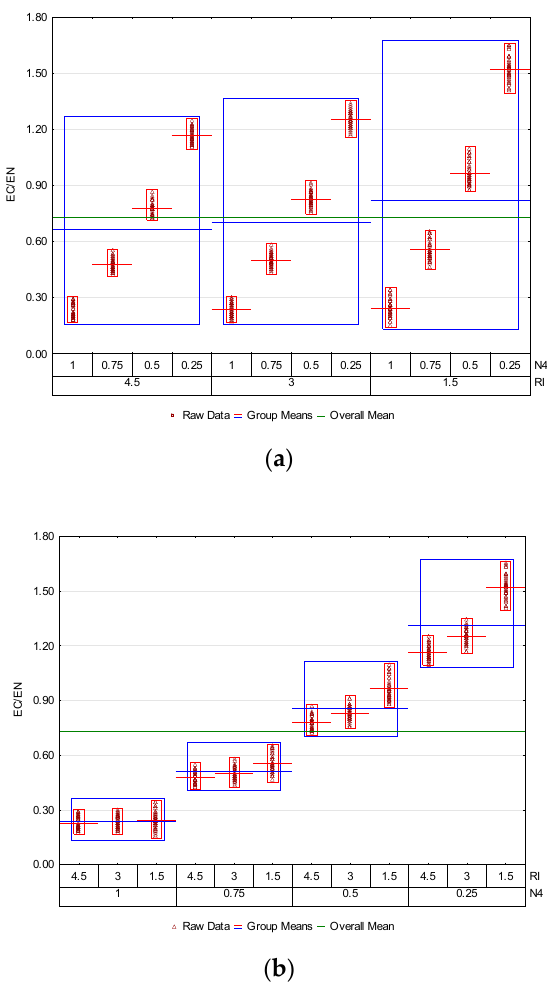
Figure 6. Variability plots of EC / EN illustrating: ( a ) N4 impact for various RI; ( b ) RI impact for various N4.